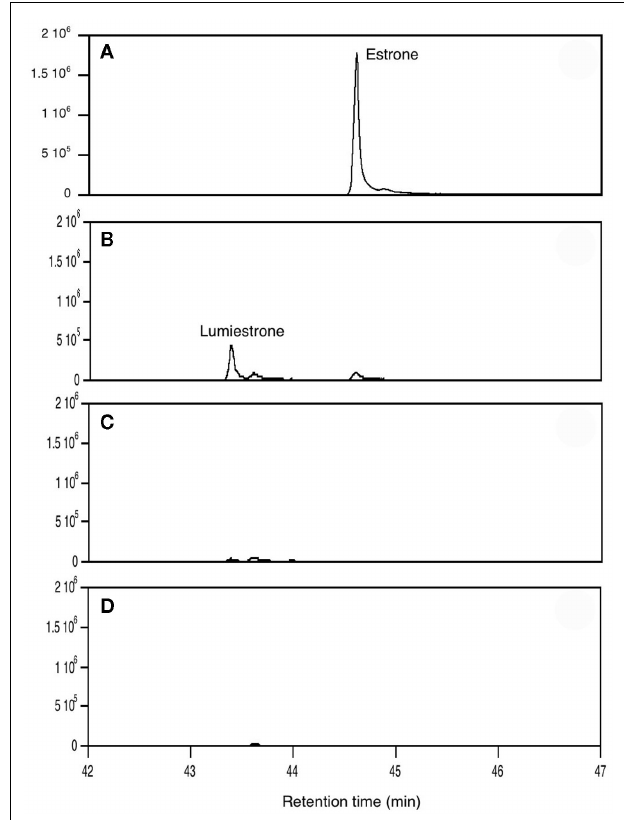
FIGURE 1 | Conversion of estrone into lumiestrone in acetonitrile following exposure to UV-B radiation, followed by gas chromatography. Irradiation times were (A) 0min, (B) 5min, (C) 15min, (D) 30min.